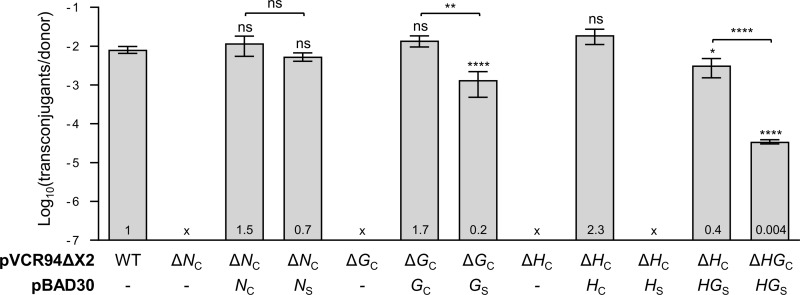
Role of TraN/G/HC on conjugative transfer of IncC plasmids.Effect of traNC, traGC and traHC on conjugative transfer of pVCR94ΔX2. Conjugation assays were carried out using E. coli BW25113 Nx containing the indicated elements as donor strains and E. coli CAG18439 (Tc) as the recipient strain. Wild-type (WT) or derivative mutants of pVCR94ΔX2 as well as the gene expressed from pBAD30 are indicated below each graph; (-) indicates that the plasmid is not present in the donor cell. For clarity, gene names traXY were shortened XY. Transfer frequencies are expressed as the number of transconjugants per NxR KnR SpR donor CFUs and the ratio of transfer frequencies relative to WT is indicated at the base of each bar. The bars represent the mean and standard deviation values obtained from at least three independent experiments. “x” indicates that the frequency of transfer was below the detection limit (<10−7). Statistical analyses were carried out on the logarithm of the values using the one-way ANOVA with Tukey’s multiple comparison test. Statistical significance is indicated as followed: ****, P < 0.0001; ***, P < 0.001; **, P < 0.01; *, P < 0.05; ns, not significant.